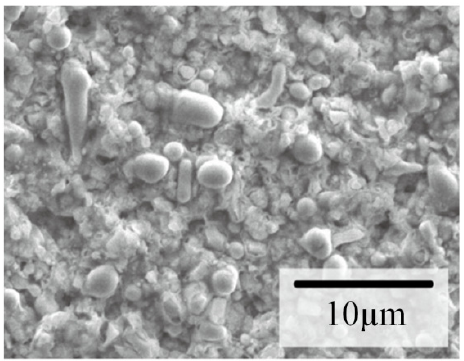
Figure 5. A microstructure of the oxide glass lattice with the metallic glass particles dispersion observed by a scanning electron microscopy.